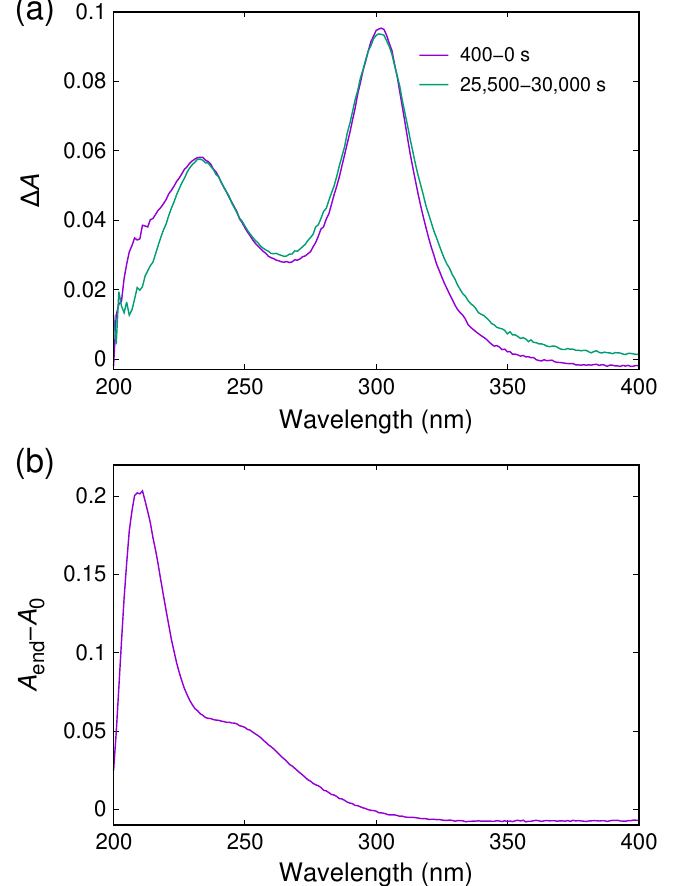
Figure 3. Difference absorption spectra from the experiment in Figure 2. The values of the absorbance difference between the given times ( a ) and between the end (>16 h) and the beginning of the reaction ( b ) are